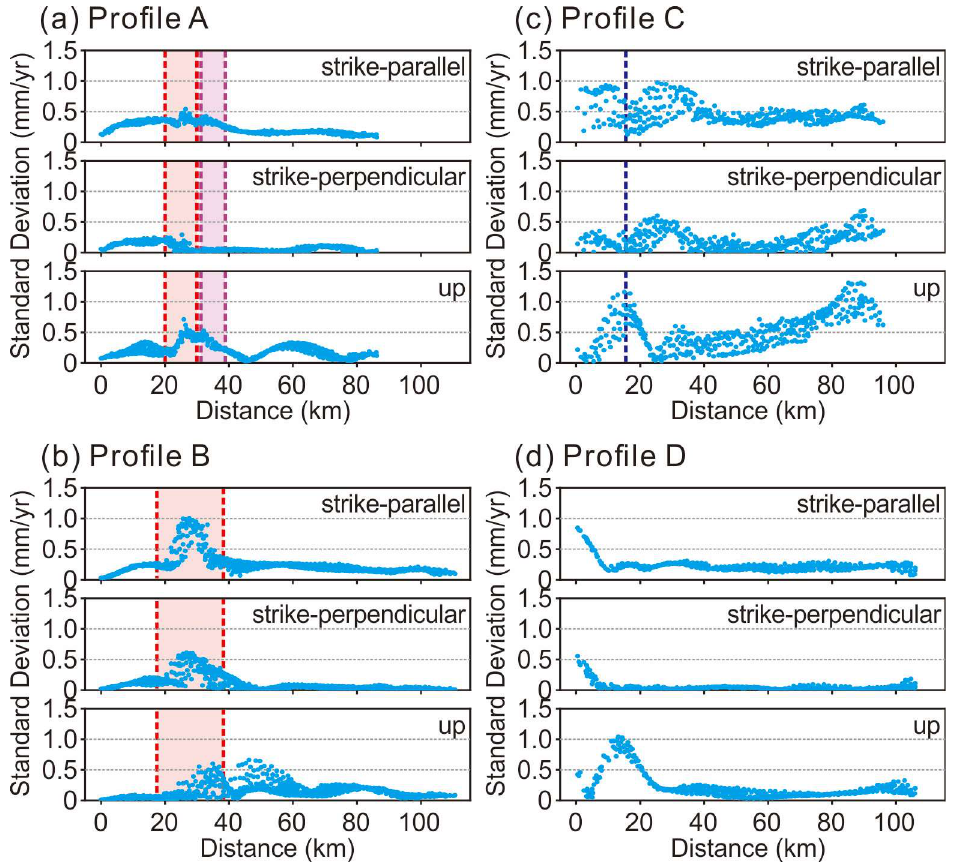
Figure 8. The standard deviation for the model velocity along the profiles.